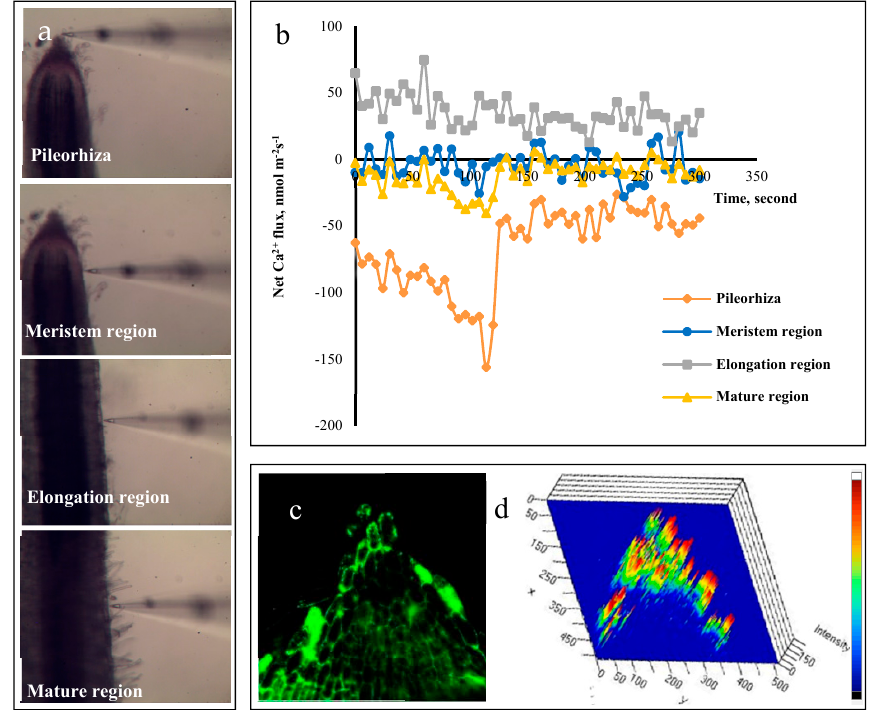
Figure 3. The flux and distribution of Ca 2+ in different parts of Phyllostachys edulis root tips under drought stress. ( a , b ) Net Ca 2+ fluxes in different parts of root tip of P. edulis seedlings under drought stress induced by 20% PEG for 10 min. At each position, an average Ca 2+ flux was measured for 5 min before the electrode was repositioned (Data Repetition: 6 replicates). ( c ) Green fluorescence intensity is positively correlated with the Ca 2+ concentration. The Ca 2+ fluorescence localization at the root tip of the P. edulis seedlings treated with PEG-simulated drought stress for 10 min. ( d ) A heat map of a further analysis for ( c ), which clearly presented that the concentrated distribution of Ca 2+ was in the pileorhiza of the P. edulis root tip cells under drought stress.